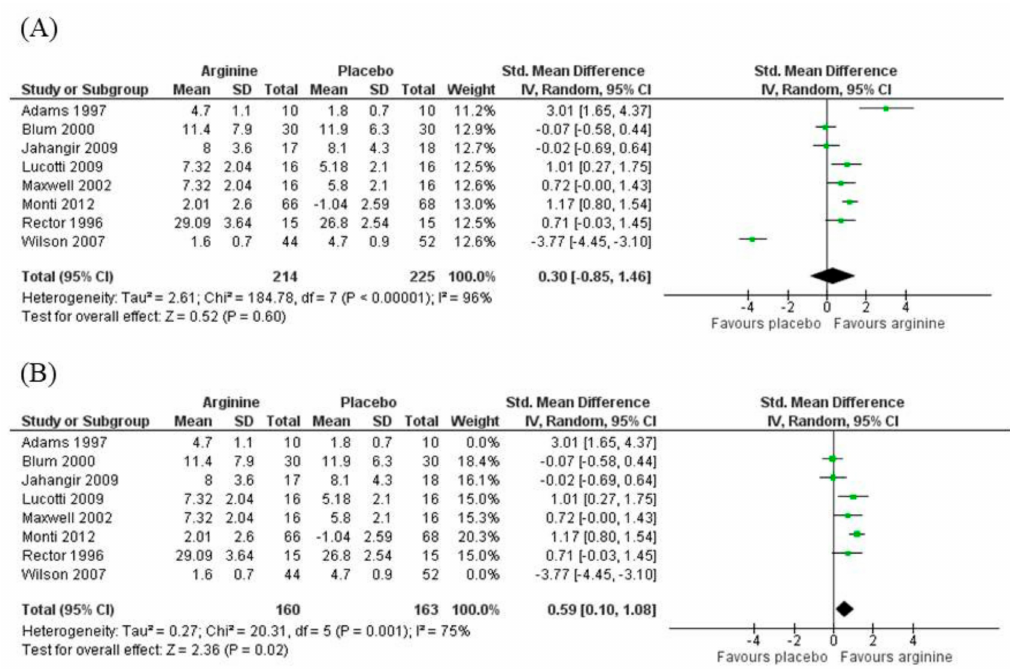
Figure 3. ( A ) Blood flow responses of individual studies: L -arginine vs. placebo treatment. ( B ) Sensitivity analysis of blood flow responses of individual studies: L -arginine vs. placebo treatment (removing the studies that most favor arginine and placebo). SD = standard deviation; CI = confidence